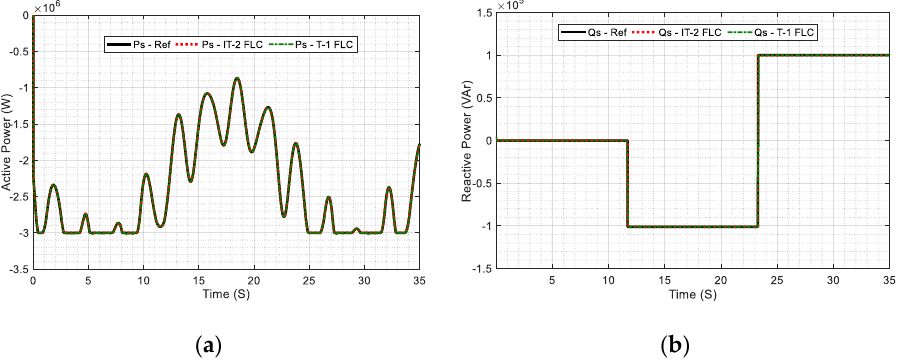
Figure 11. ( a ) Active power ( 𝑃 𝑠 ) comparison under normal conditions; ( b ) reactive power ( 𝑄 𝑠 ) comparison under normal conditions.